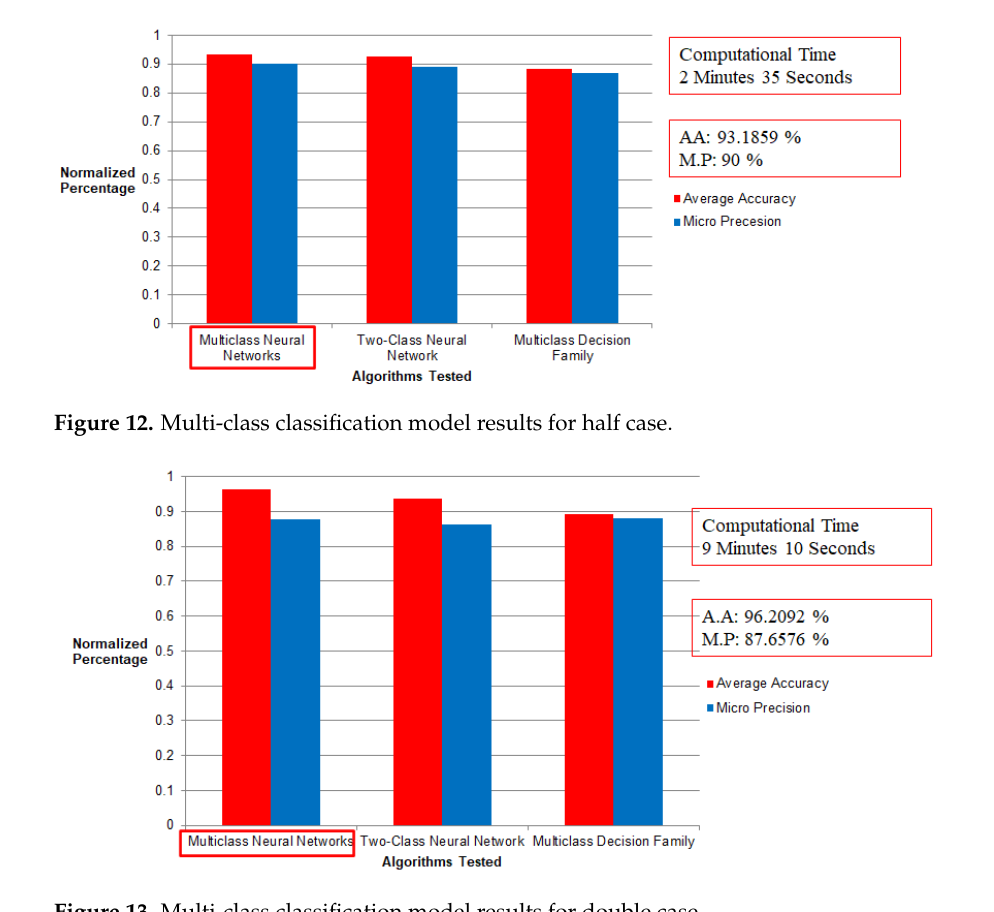
Figure 13. Multi-class classification model results for double case.